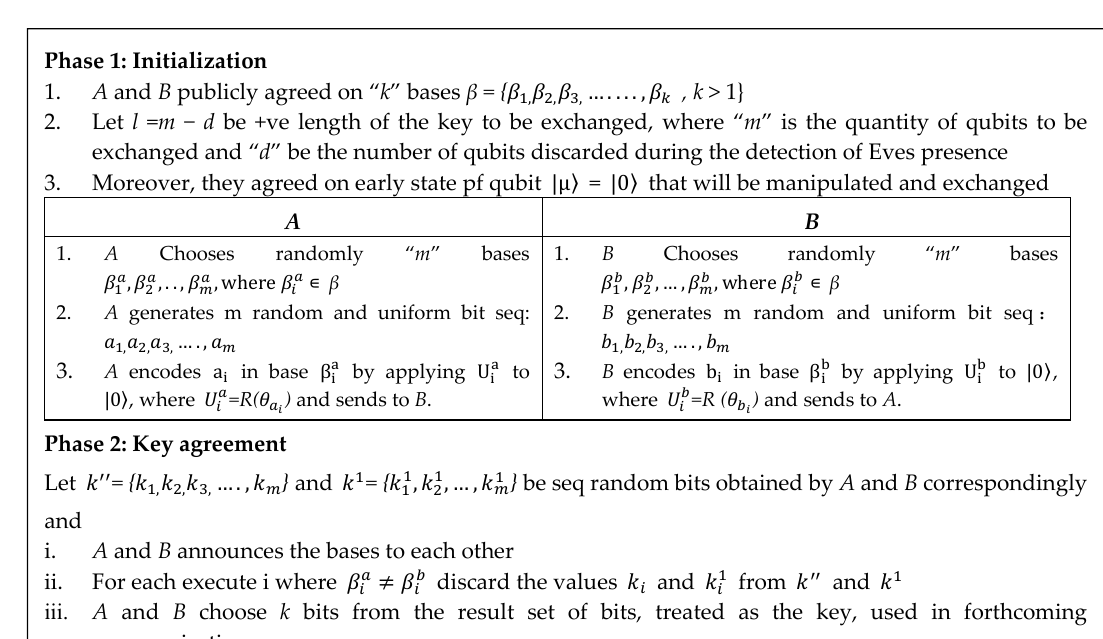
Figure 2. Two-party quantum key agreement algorithm.